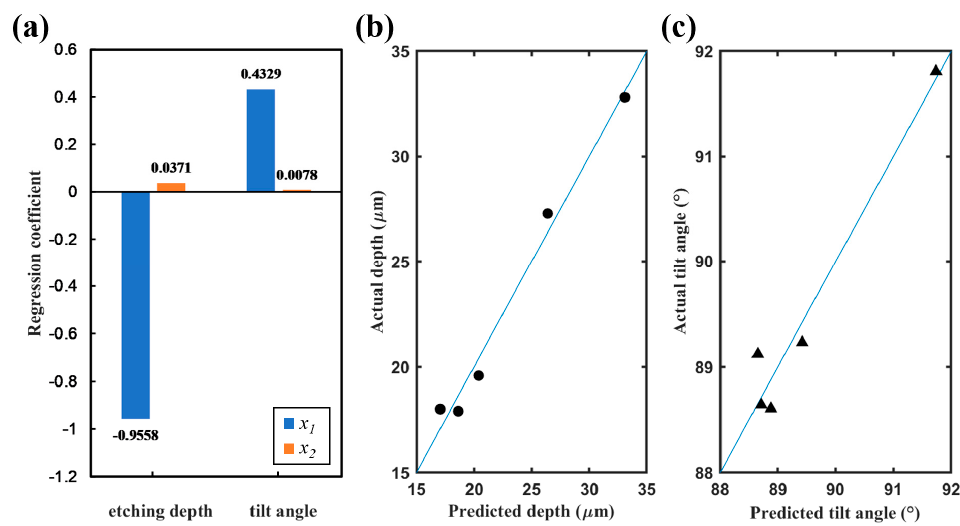
Figure 7. PLS regression model of cryogenic etching: ( a ) histogram of regression coefficients, ( b ) prediction graph of etching depth, and ( c ) prediction graph of tilt angle.